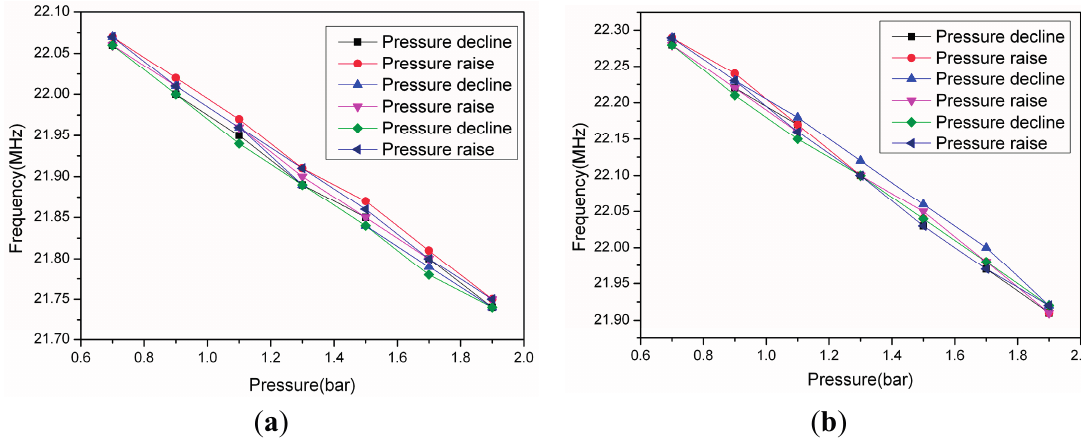
Figure 14. ( a ) The resonant frequency of the sensor versus pressure at 800 °C; ( b ) The resonant frequency of the sensor versus pressure at 600 °C.